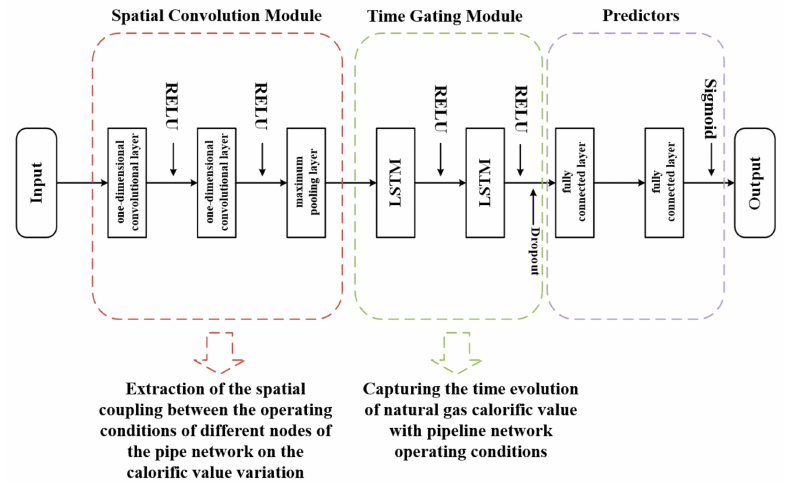
Figure 3. Schematic diagram of deep − learning model